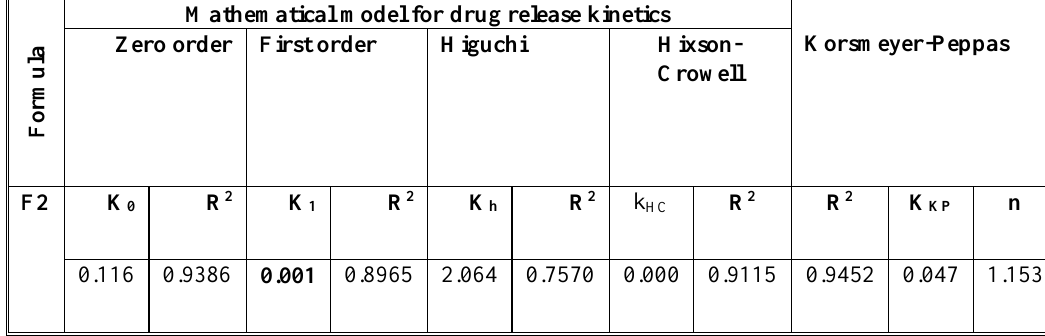
Figure 8. Effect of stirring speed on % drug release from F2, F6 and F7. Table 3 . Kinetic analysis of ACV release data from F2 microsponge